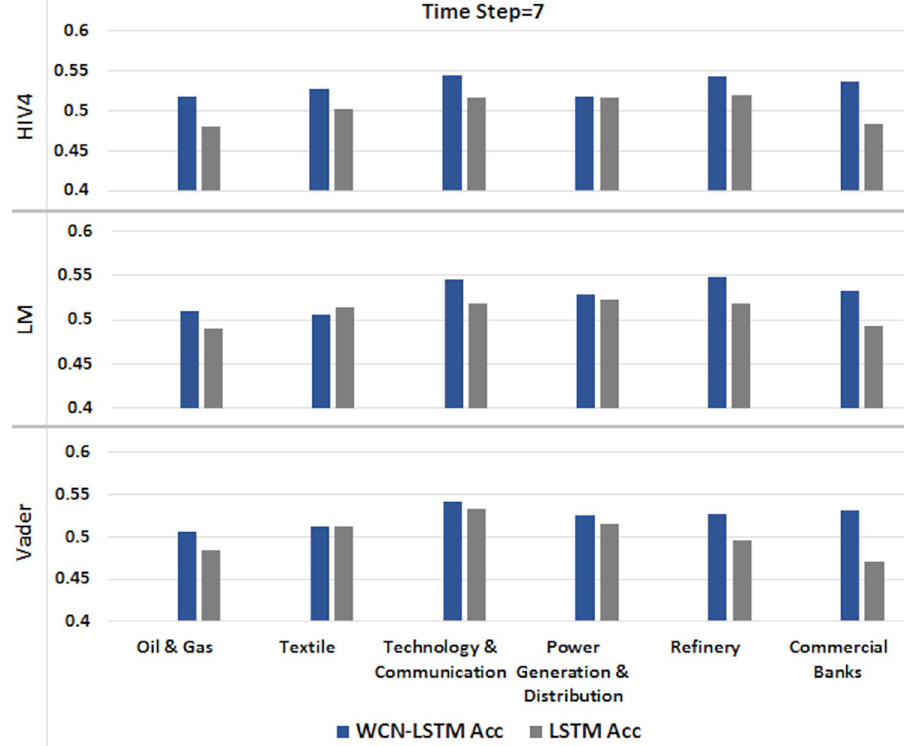
Fig 11. Comparison among sectors for time step = 7.